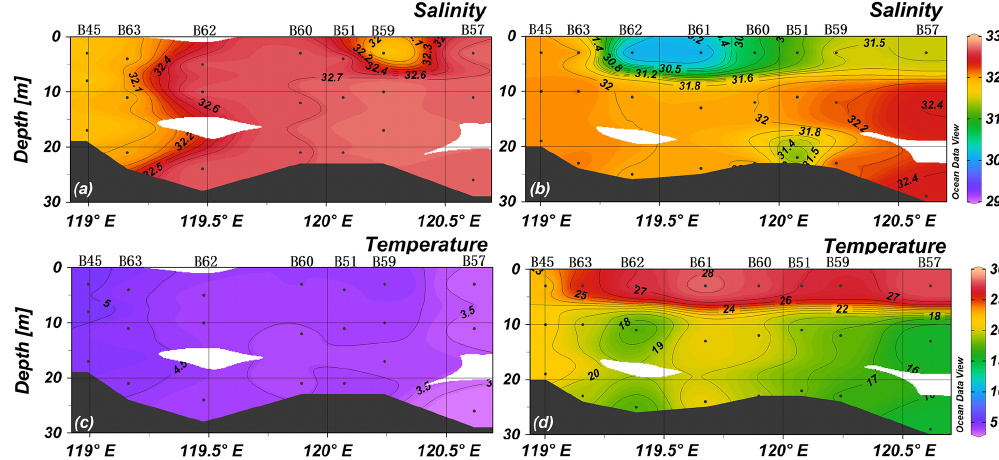
Figure 2. Temperature ( ◦ ) and salinity of section 1 for spring (a, c) and summer (b, d) .